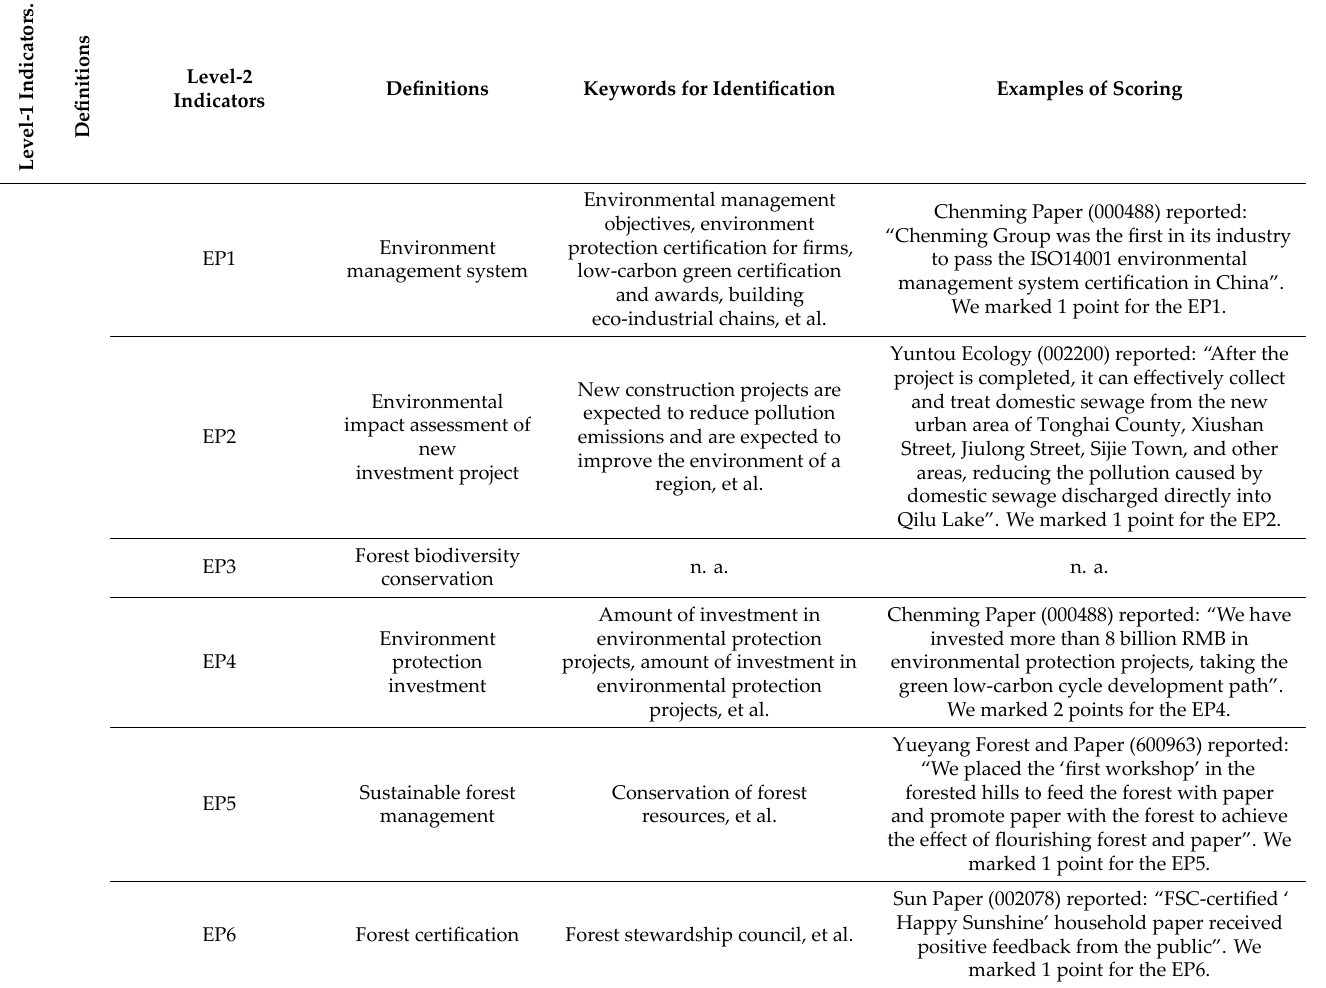
Table A1. CSR content analysis system and examples of social media from WeChat Official